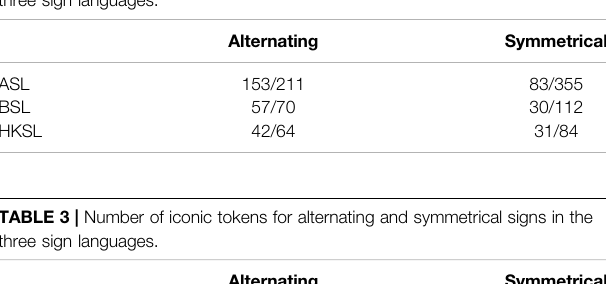
Alternating Symmetrical